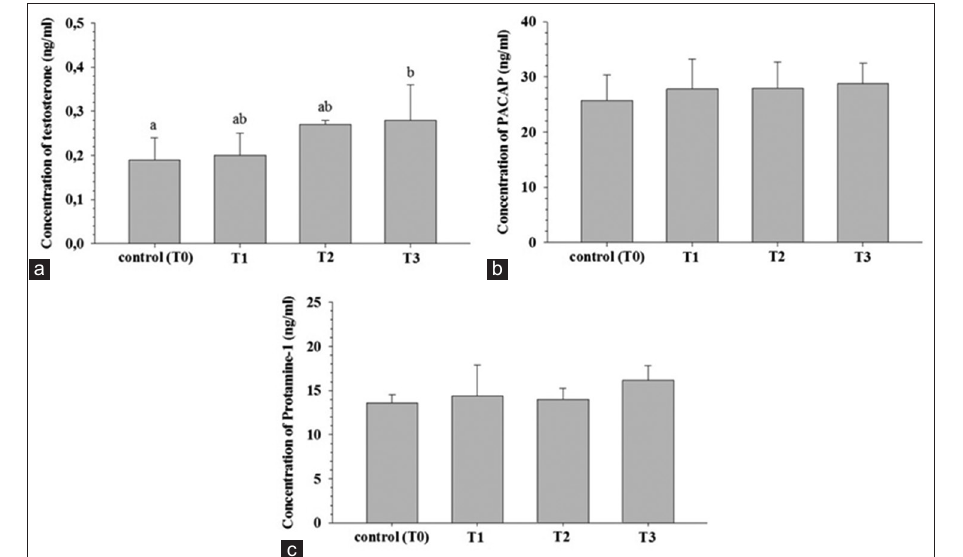
Figure-1: The concentration (mean ± standard deviation) of testosterone (a), pituitary adenylate cyclase-activating polypeptide (b), and protamine 1 (c) after injected with epididymis and testicular extracts and their combination in male chicken. Different superscripts indicate a statistically significant difference between groups